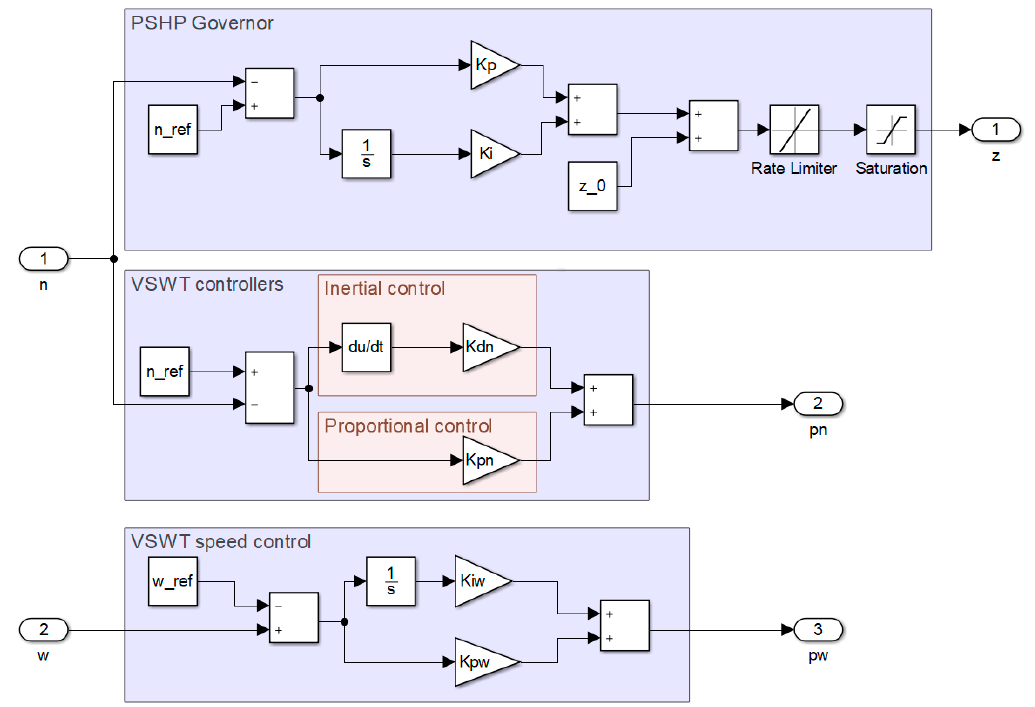
Figure 5. Block diagram of the hybrid wind–hydro controllers.